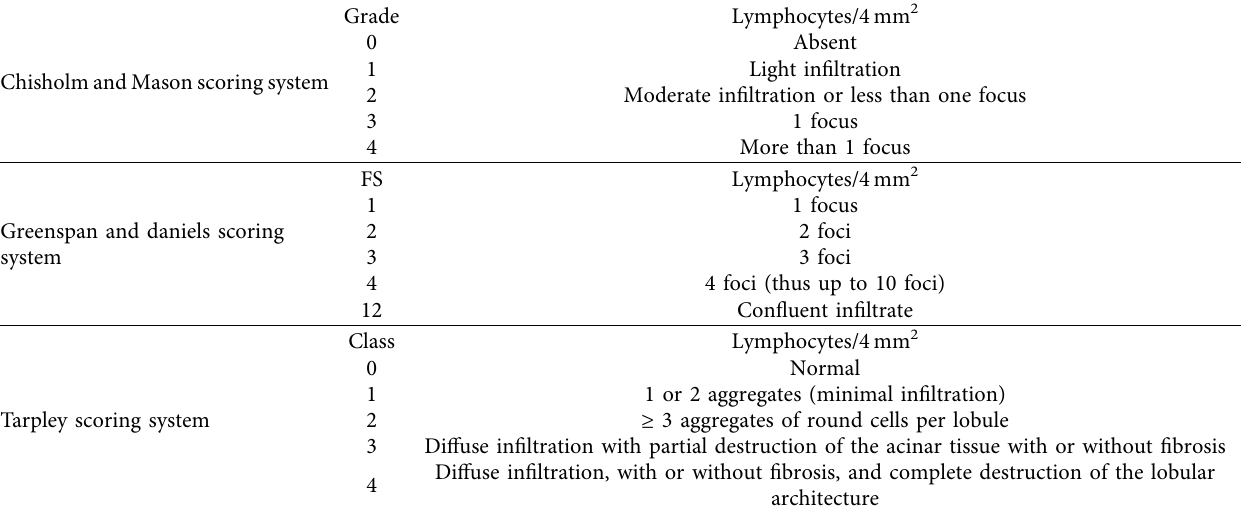
Table 6: SS histopathological scoring